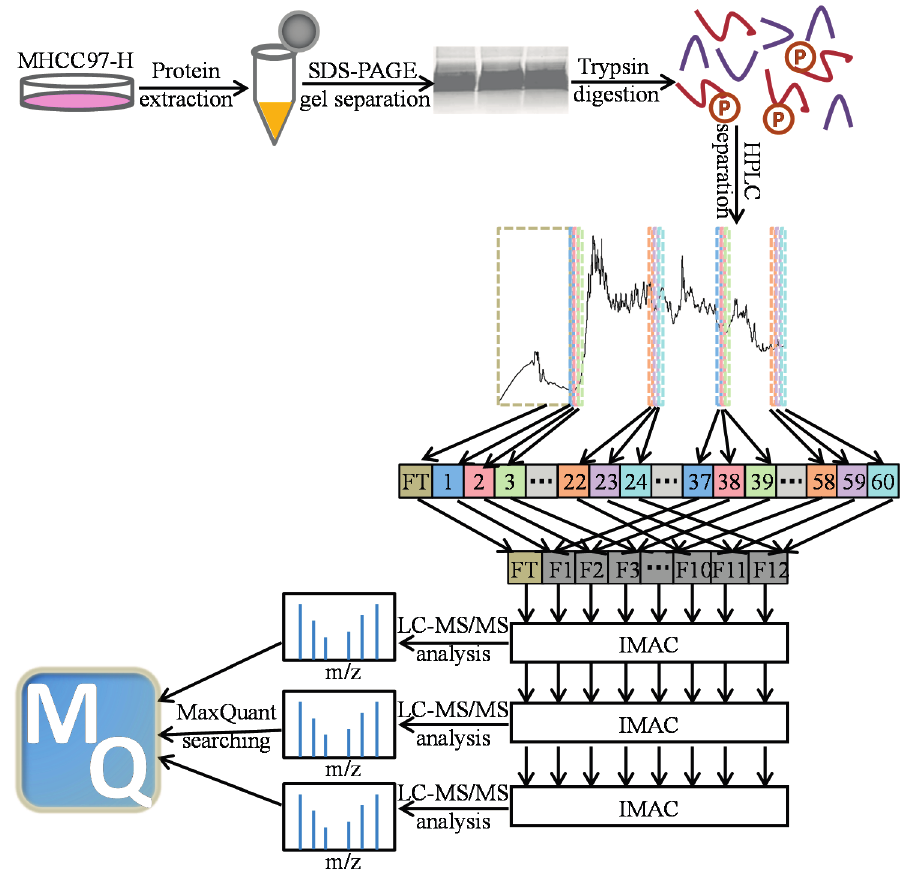
Figure 1. Scheme for sample preparation, HPLC multi-IMAC (Immobilized Metal ion Affinity Chromatography) methods and data processing of MHCC97-H (high metastasis)